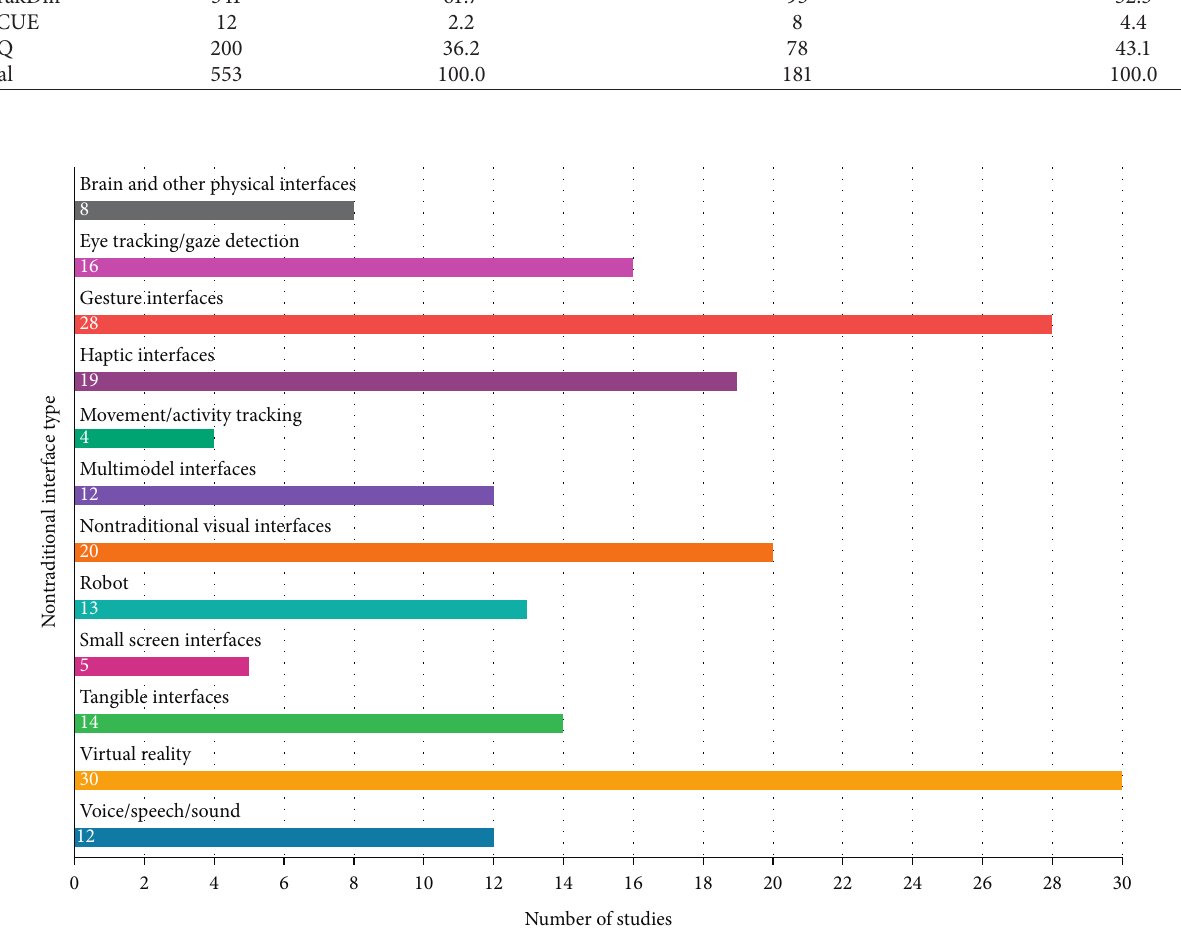
Table 8: Percentage of standardized questionnaires in studies with nontraditional interfaces. All studies